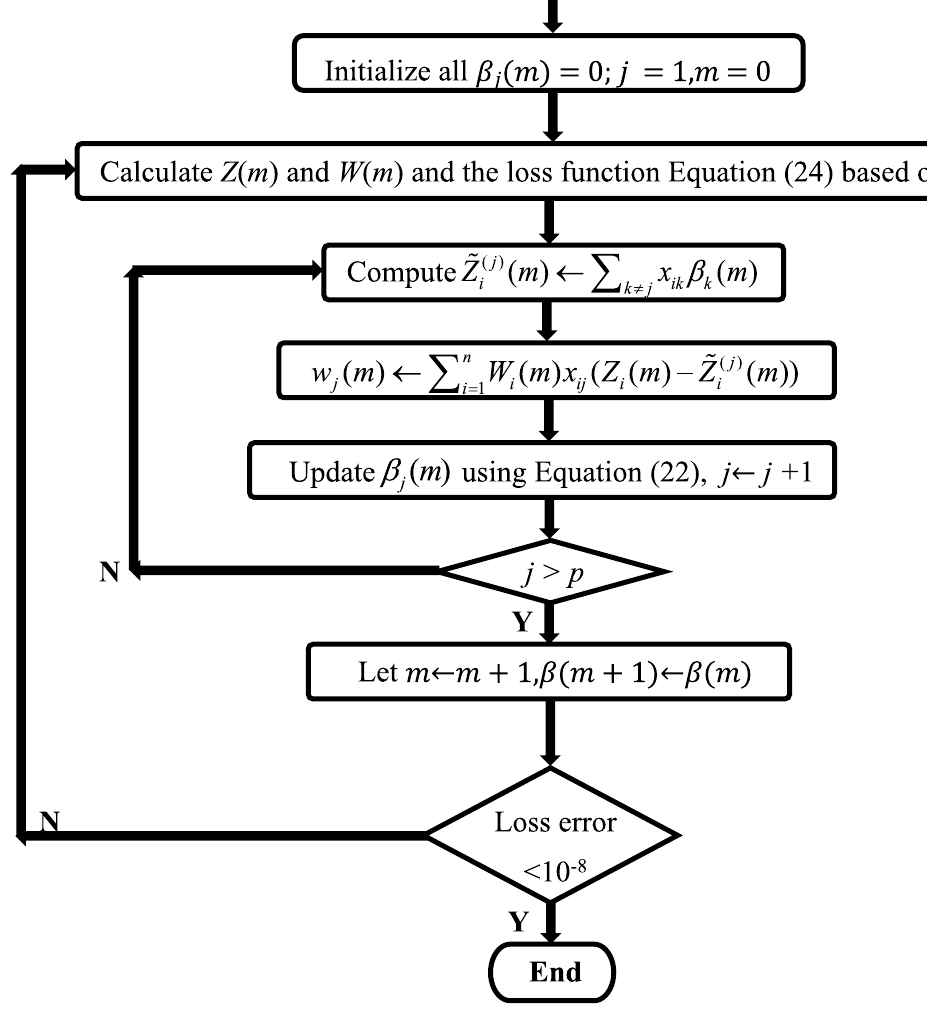
Figure 3. Flowchart of the coordinate descent algorithm for the LogSum + L 2 penalized logistic regression